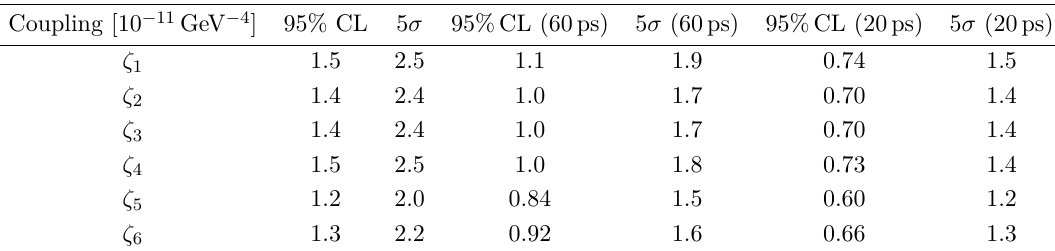
Table 3. 95 % CL and 5 σ projected limits on each of the couplings, setting the other ones to zero. Multiple timing detector performance scenarios are considered: no timing information, timing detector resolution σ = 60 ps, and timing detector resolution σ t